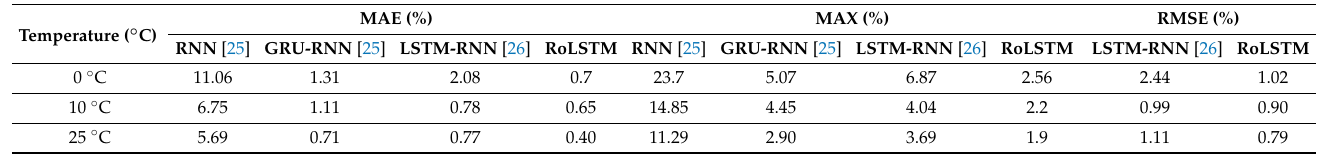
Table 3. Comparison of MAE (%), MAX (%), and RMSE (%) SOC estimation for Panasonic 18650PF